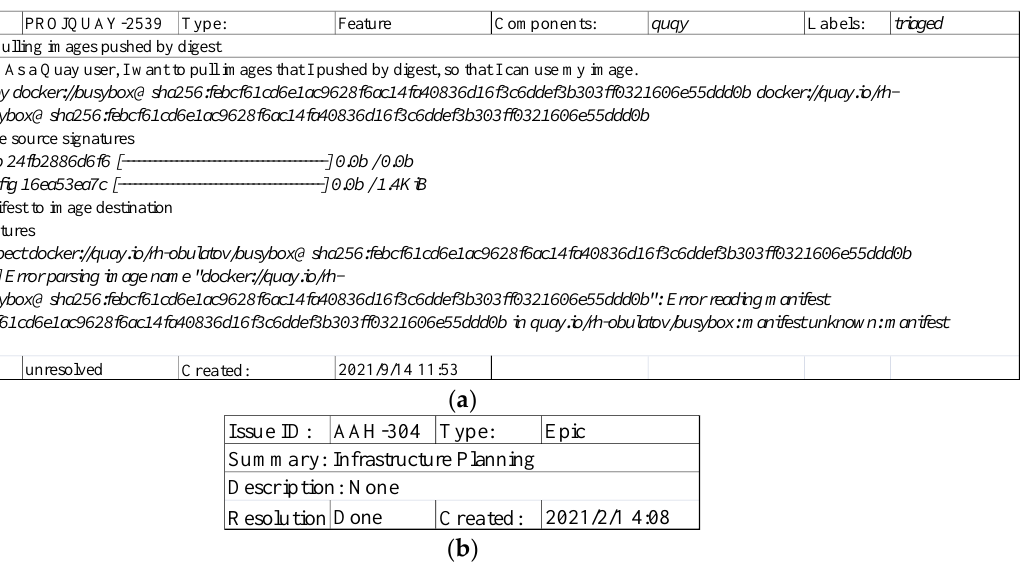
Figure 9. Examples of requirement descriptions that are less standard. ( a ) PROJQUAY-2539 with which debugging information is more than natural language text. ( b ) AAH-304 in which the text is too short.